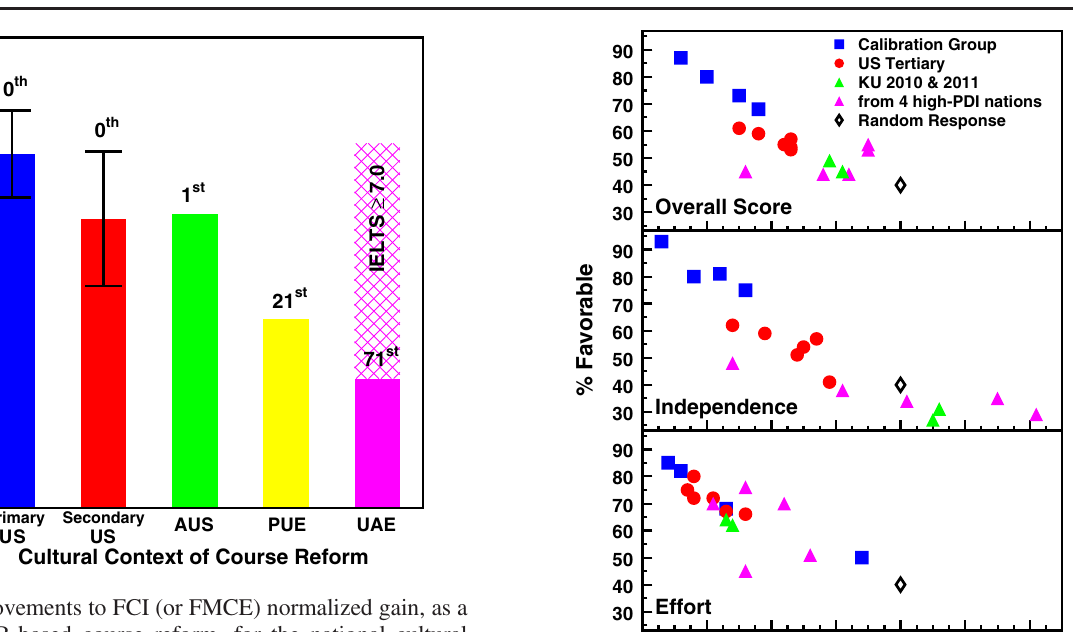
FIG. 1. Improvements to FCI (or FMCE) normalized gain, as a result of a PER-based course reform, for the national cultural contexts of the reforms. Error bars for Primary U.S. and Secondary U.S. cases are standard errors in the average, taken over the available cases in the literature. AUS, PUE, and UAE represent single SIs conducted for predominantly Australian, Puerto Rican, and Emirati student populations, respectively. Above each entry, the rank out of 79 is given for “ cultural distance ” relative to U.S. national culture, computed by calculat- ing the geometric distance from the U.S. score on Hostede ’ s dimensions and ranking the results in ascending order. A low rank indicates relative cultural similarity to U.S. national culture, in Hofstede ’ s framework. A high rank indicates relative dissimilarity. Improvement to FCI normalized gain is replotted (purple, cross-hatched) for UAE, for only those students in the CWP reform with high English language proficiency (i.e., IELTS score).